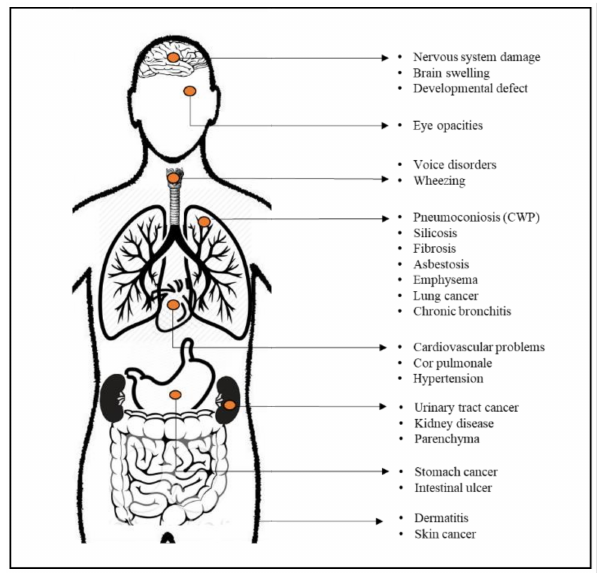
Figure 4. Health effects of RCMD exposure and disease